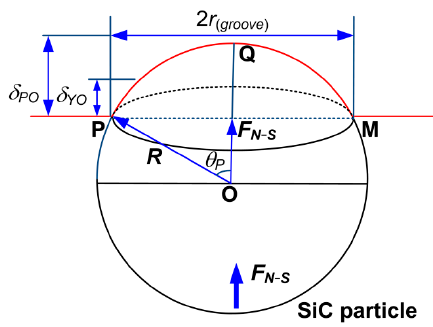
Figure 3. Particle element analysis.